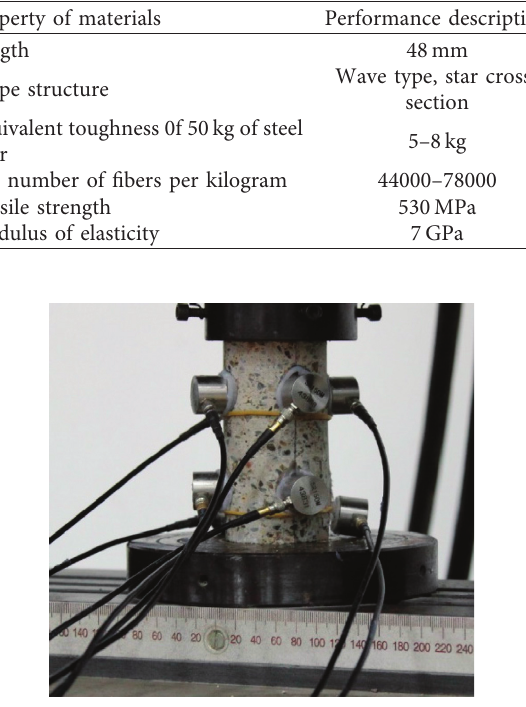
Figure 2: Loading device and arrangement of AE sensors.